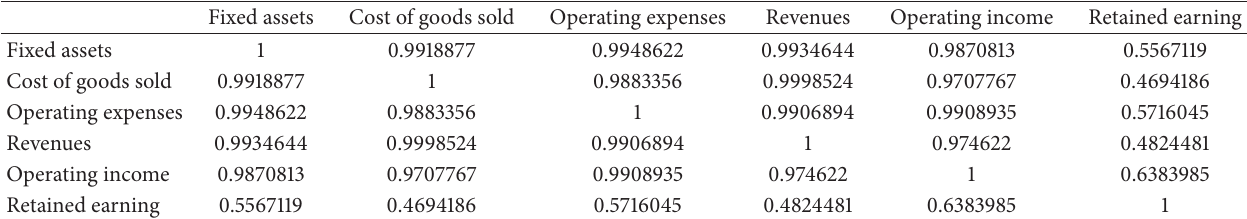
Table 7: Correlation of input and output data in 2009.